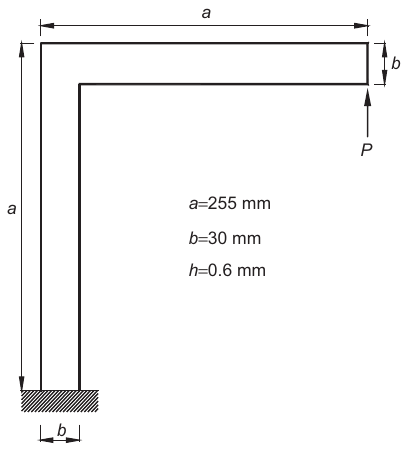
Figure 4 Clamped L-shaped plate subjected to in-plane load at the free end.